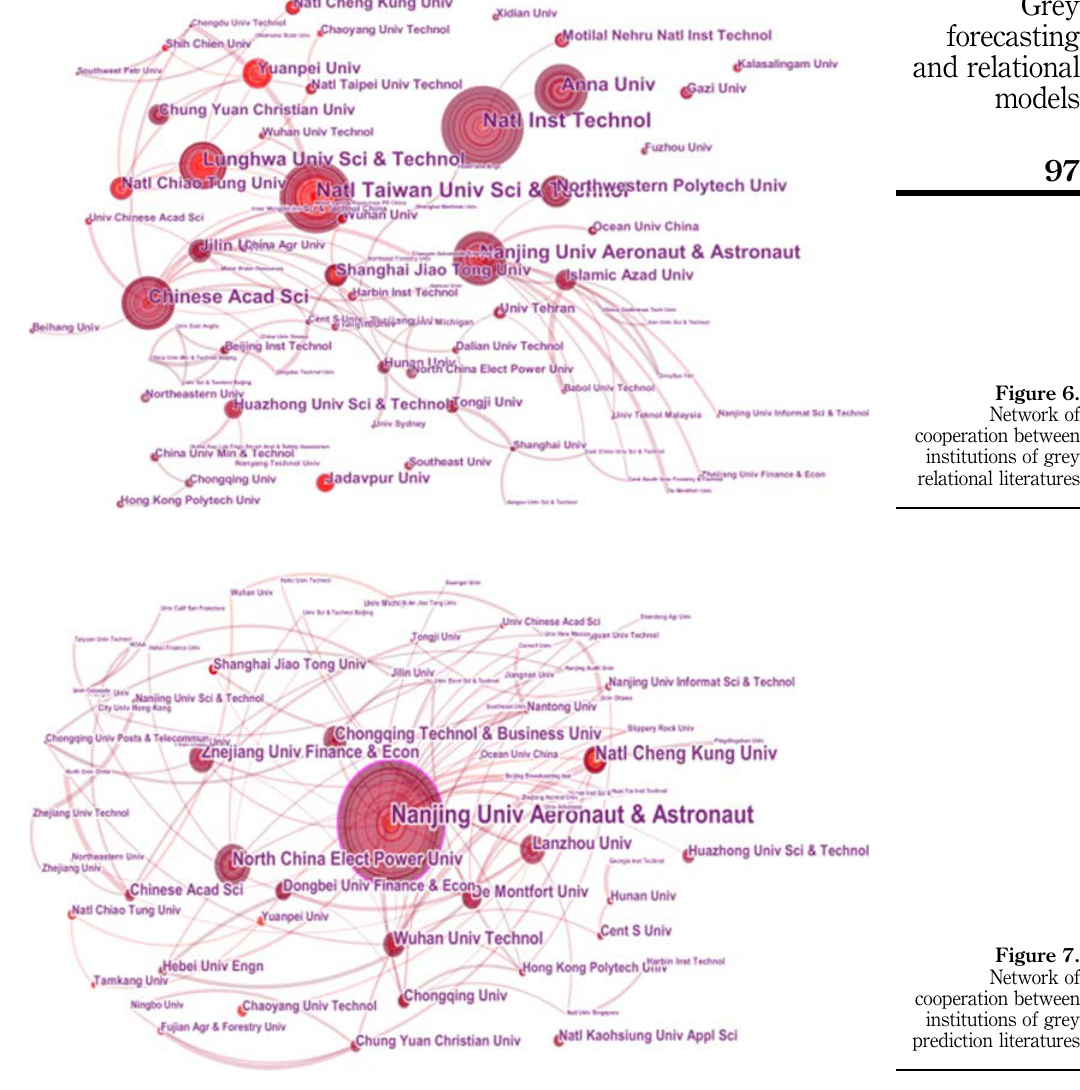
Figure 7. Network